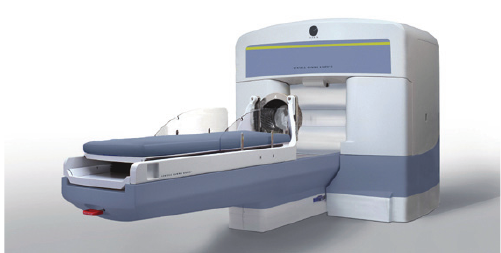
Figure 8: The gamma knife machine (courtesy of